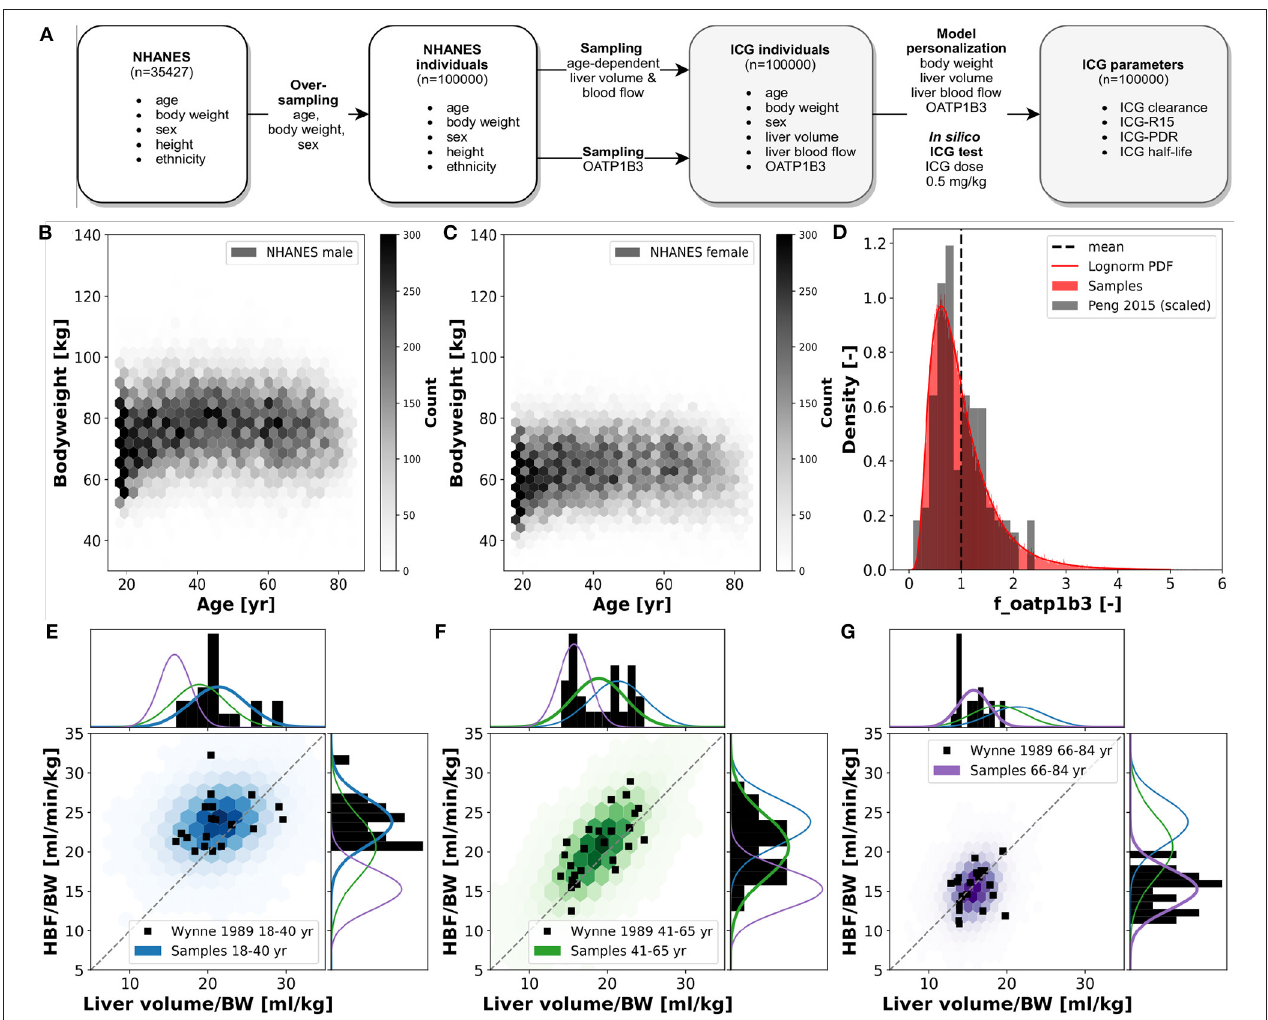
FIGURE 5 | In silico population: ICG elimination was simulated for an in silico population consisting of n = 100,000 individuals (see Figure 1E for workflow). Subjects are sampled form the NHANES cohort thereby accounting for the existing covariances between sex, age, body weight, height and ethnicity. (A) Workflow to simulate ICG elimination in a large in silico population consisting of n = 100,000 individuals. (B,C) Dependency of body weight on age in men and women. Data from NHANES (NHANES, 1999-2018) depicted as hexbin with shading corresponding to number of subjects (hexbins containing ≥ 300 subjects are encoded in black). (D) Lognormal density distribution of OATP1B3 amount. Clinical data (gray) from Peng et al. (2015) was normalized to the the model parameter f_oatp1b3 describing the change in OATP1B3 amount relative to the model reference value. (E–G) Distributions of hepatic blood flow per kg body weight and liver volume per kg body weight in three different age groups: blue, 18–40 year; green, 41–65 year; purple, 66–84 year. Clinical data (black) from Wynne et al.